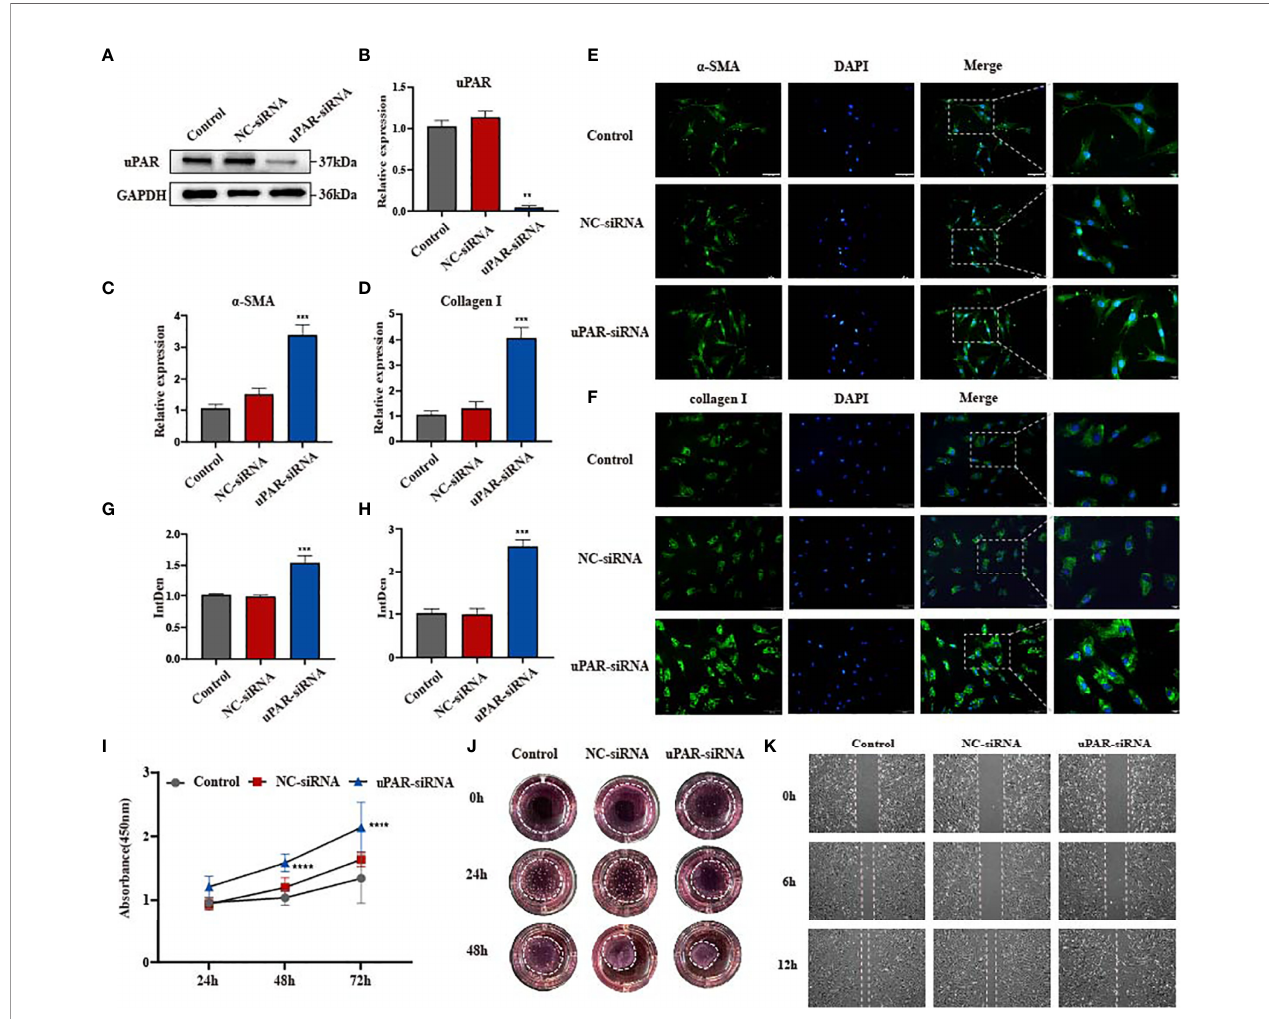
FIGURE 2 | Knockdown of uPAR promotes fi brosis progression in vitro. (A, B) The knockdown ef fi ciency of uPAR-siRNA in disease-derived fi broblasts was con fi rmed by western blot and qPCR. (C, D) mRNA level of a -SMA and type I collagen in three groups of cells. (E – H) Immuno fl uorescence staining of a -SMA and type I collagen in three groups of cells and their integrated density. scale bars, 100 m m, 20 m m. (I) The proliferation ability after knocking down uPAR was evaluated by the cell counting kit 8. (J) Effect of knocking down uPAR on the contractility of fi broblasts. (K) The migration ability of fi broblasts after knocking down uPAR was evaluated by wound-healing assay. **P < 0.01, ***P < 0.001, and ****P < 0.0001 when compared between the denoted